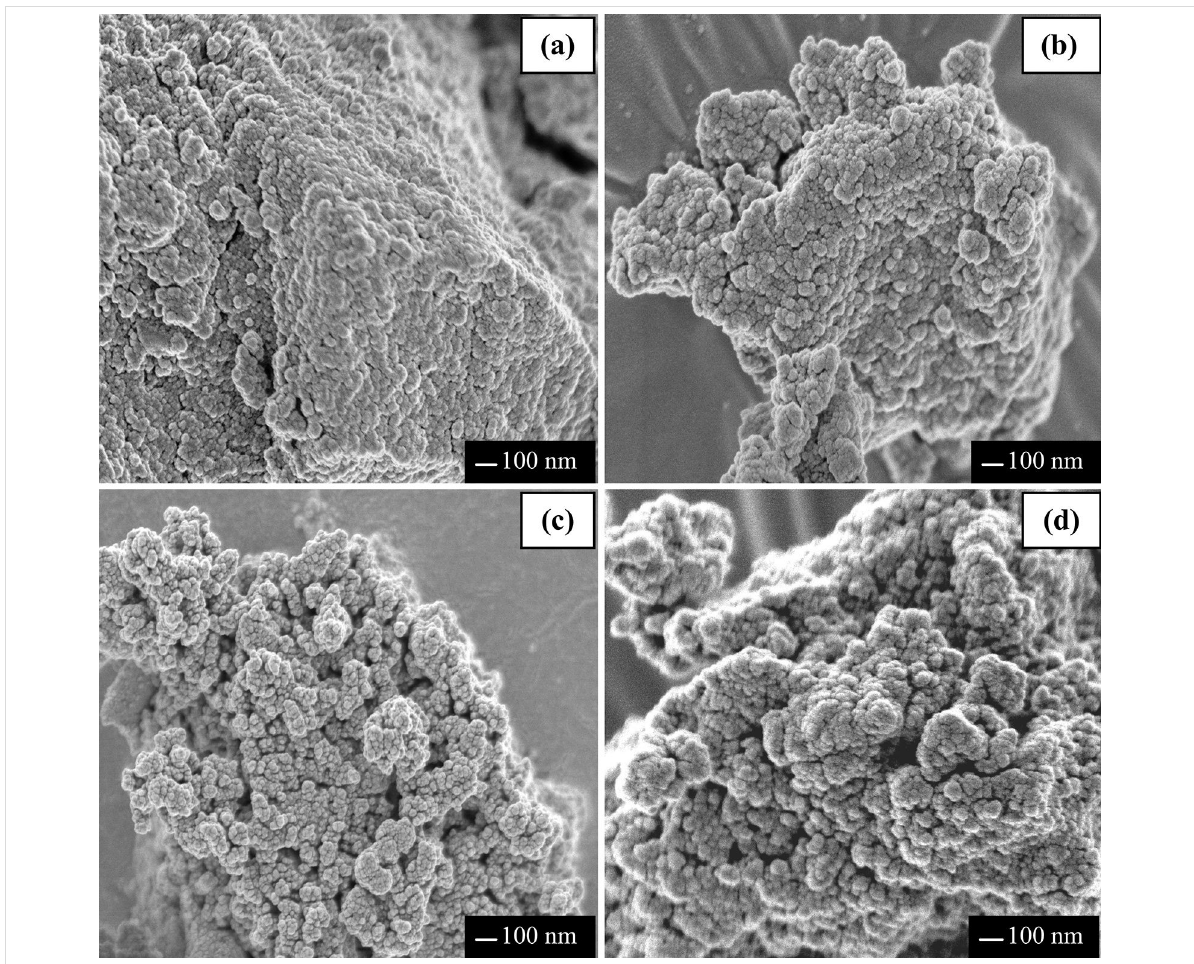
Figure 4: FESEM images of (a) Cd 0.1 Zn 0.9 S, (b) Ag(0.01)-doped Cd 0.1 Zn 0.9 S, (c) Ag(0.03)-doped Cd 0.1 Zn 0.9 S (d) Ag(0.05)-doped Cd 0.1 Zn 0.9 S prepared by the co-precipitation method.